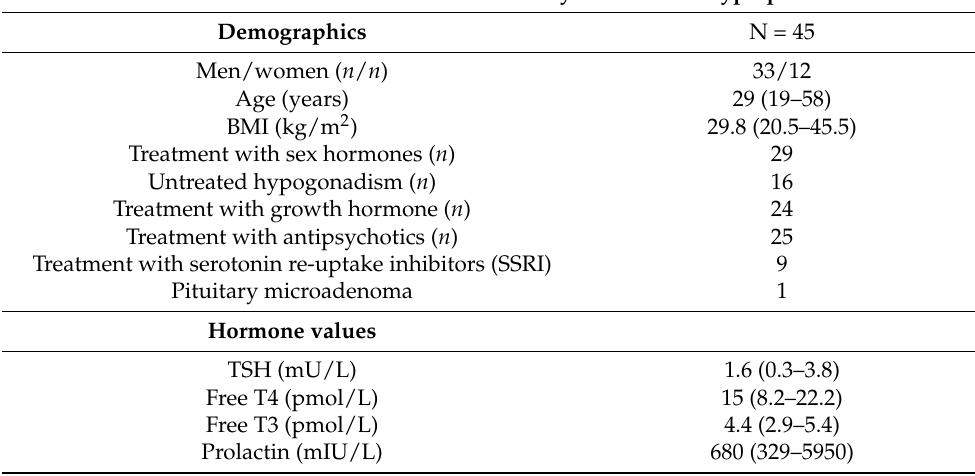
Table 1. Characteristics of 45 adults with Prader-Willi syndrome and hyperprolactinemia. Results are shown as median and range, unless otherwise specified.